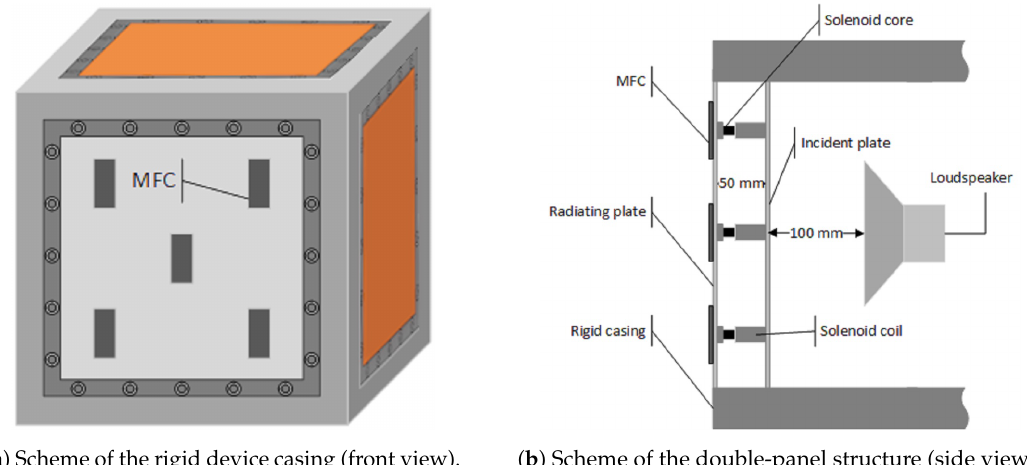
Figure 5. Schematic representation of the experimental